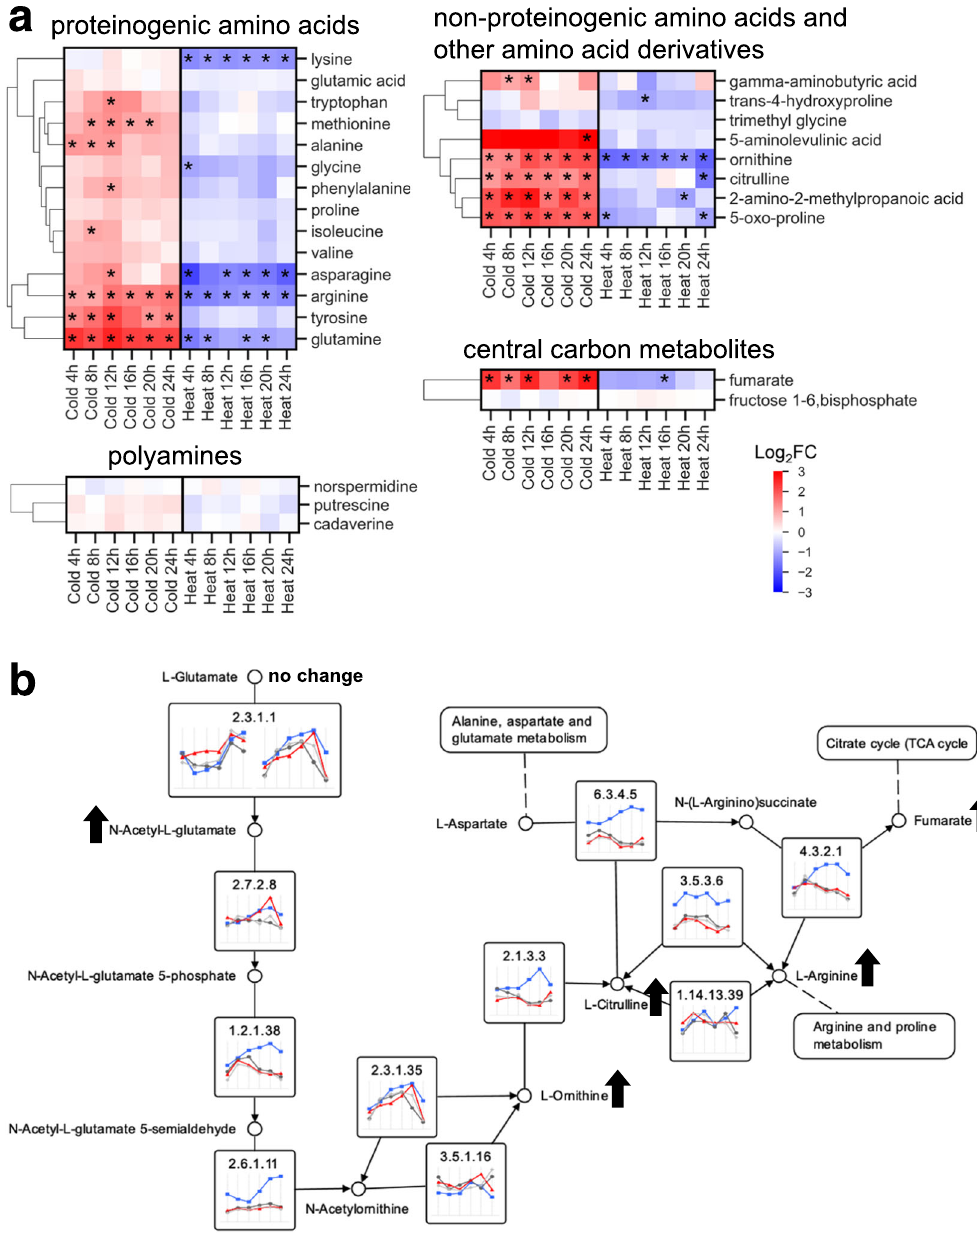
Fig. 6 Amino acid metabolism under cold stress and heat stress. a Heatmap of fold change in metabolite levels over time in cold stress and heat stress samples relative to the control samples at the corresponding time point. Asterisk (*) indicates p -value < 0.05 and absolute Log 2 FC > 1. Rows are ordered by hierarchical clustering of mean fold change over three replicates. b Pathway map based on KEGG EC annotations for the arginine biosynthesis pathway. Gene expression pro fi les (FPKM over time) are shown by gene in cold stress (blue), heat stress (red), and controls (dark gray and light gray) averaged over three replicates each. Arrows indicate the change or no change in the cold stress sample relative to the control sample for the detected